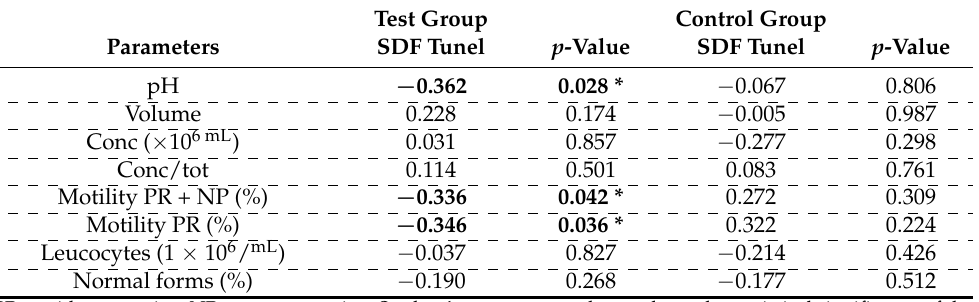
Table 3. Correlation between sperm parameters and %SDF in semen samples from the Test and Control